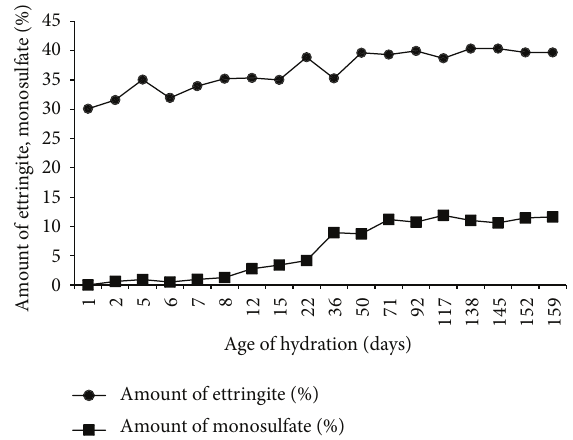
Figure 8: Average amount of ettringite and monosulfate in hydrated ye’elimite clinker exposed to environment of saturated water vapour.